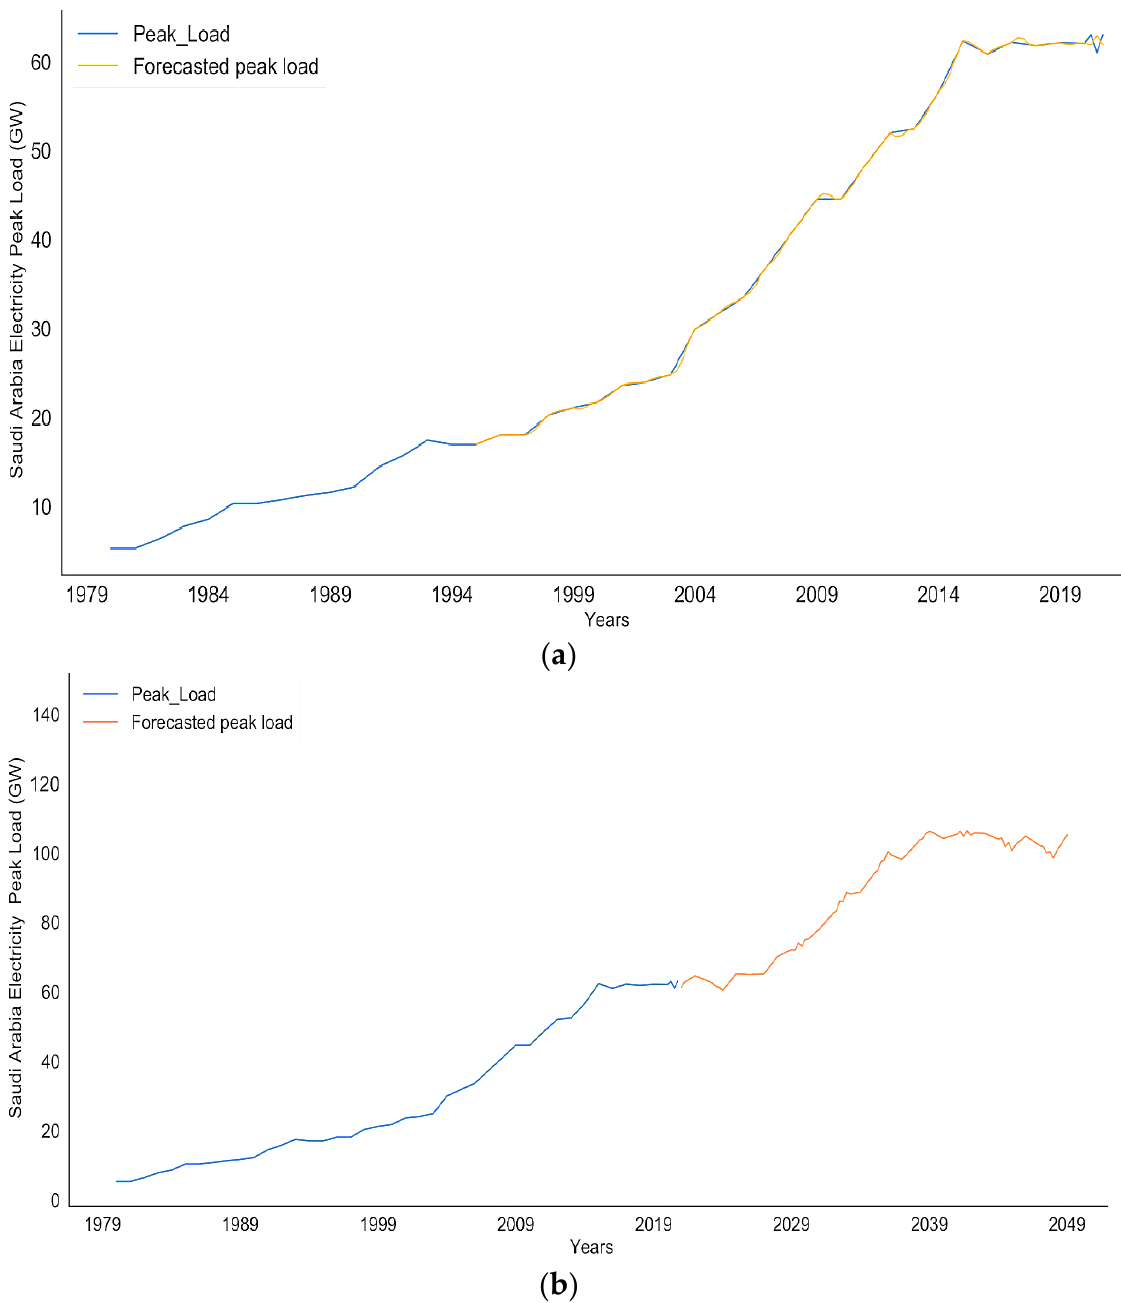
Figure 8. ( a ) Real and forecasted values of the electricity peak load, which show the good fit and performance of the SARIMAX model. ( b ) Forecasted peak electricity load values for the 30-year period from 2021 to